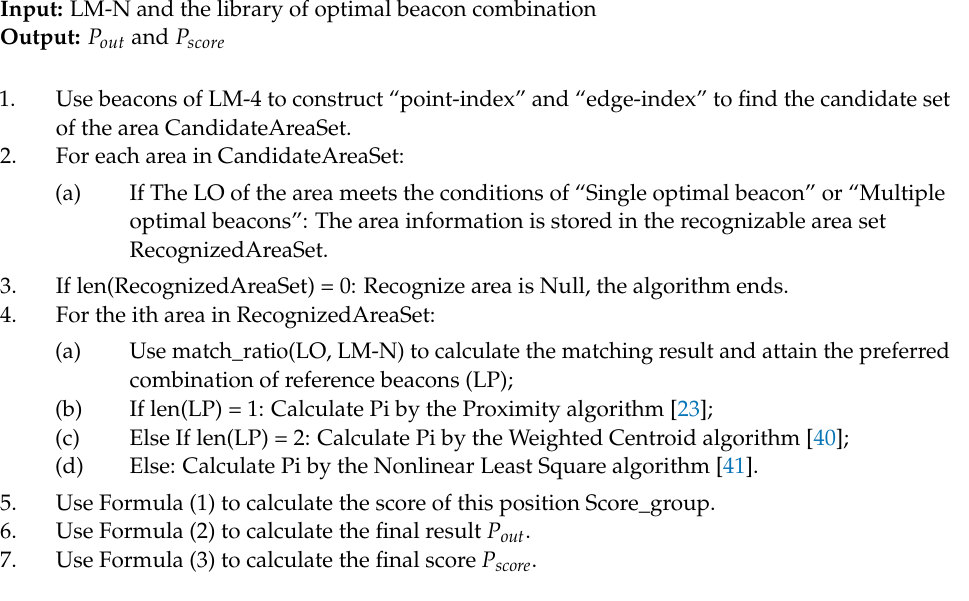
Algorithm 2 Proposed localization algorithm with optimal